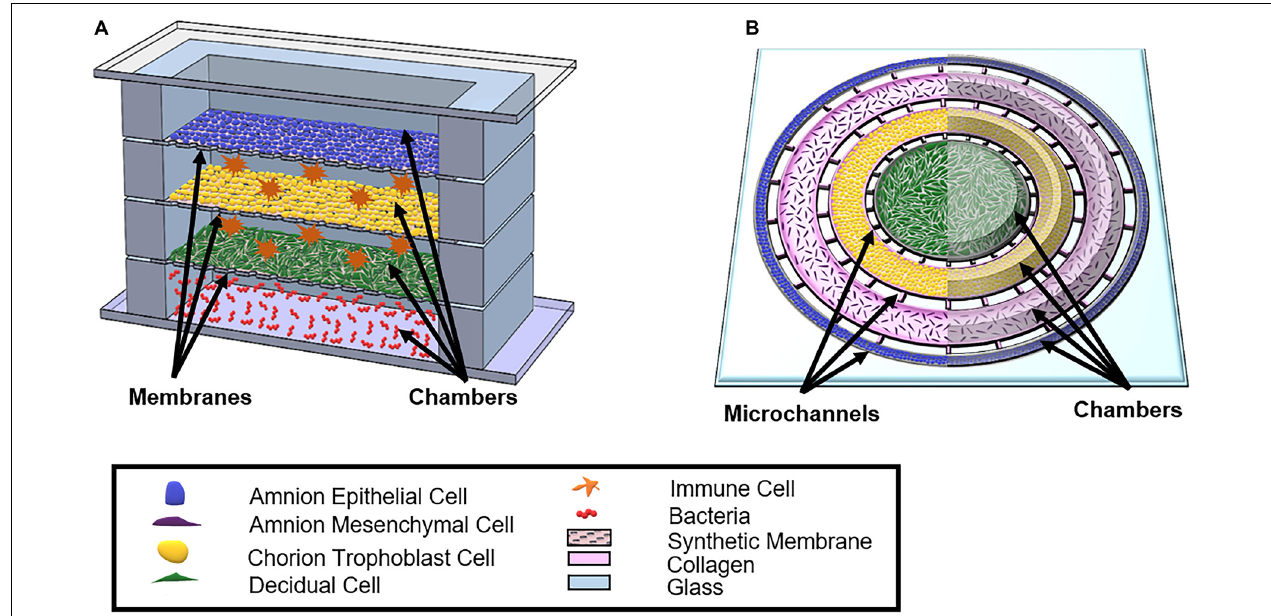
FIGURE 6 | Schematic of proposed OOCs better mimicking the full fetal membrane and feto-maternal interface. (A) A rendition of the proposed fetal membrane on a chip (IFMOC) by Gnecco et al. (2017) designed to create an infectious preterm birth model to study fetal membranes. This device contains four chambers culturing AECs (blue) on top, CTs (yellow) along with immune cells (orange) in the second chamber, decidua (green) and immune cells in the third chamber, and bacteria (red) in the bottom chamber. Each chamber is separated by a polycarbonate semipermeable synthetic membrane. (B) The proposed feto-maternal interface organ-on-chip (FMI-OOC) here is designed to mimic the feto-maternal interface, including the fetal membranes and maternal decidua. The FMI-OOC contains four co-centric circular cell culture chambers separated by arrays of microchannels. The cells are seeded following the in vivo structure; AECs (blue), AMCs (purple), CMCs/CTs (yellow), and decidua cells (green), respectively. Primary fetal membrane collagen and Matrigel (pink) can enable culturing AMCs and CMC/CTs in a 3D format. To recreate cell–collagen interfaces, microchannels can be filled with type IV collagen (pink) to mimic the basement membrane of the amnion and chorion layers, while the choriodecidua interface is left open (gray). All figures reused with permission. A comparison of both proposed OOC models can be found in Table 3 .